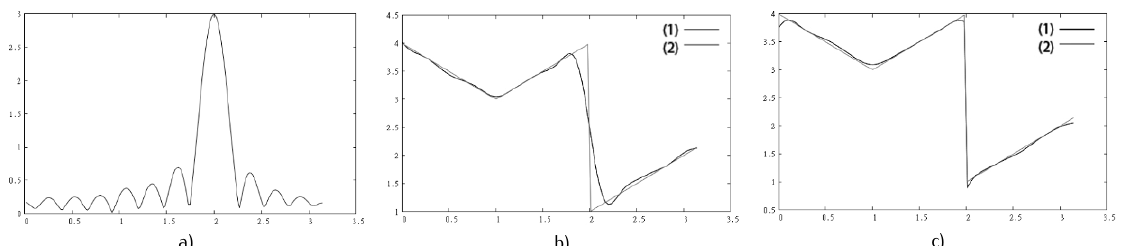
Figure 3. a) |p N ( x ) | , where N = 22 . Line (1) on b) and c): reconstruction of potential (13) , b) using the reference potential p ( x ) = (1 /π c) using the adapted reference potential p ( x ) , where we recover a = 2 . 007 , b = 2 . 989 . Line (2) in both cases is an exact function (13)